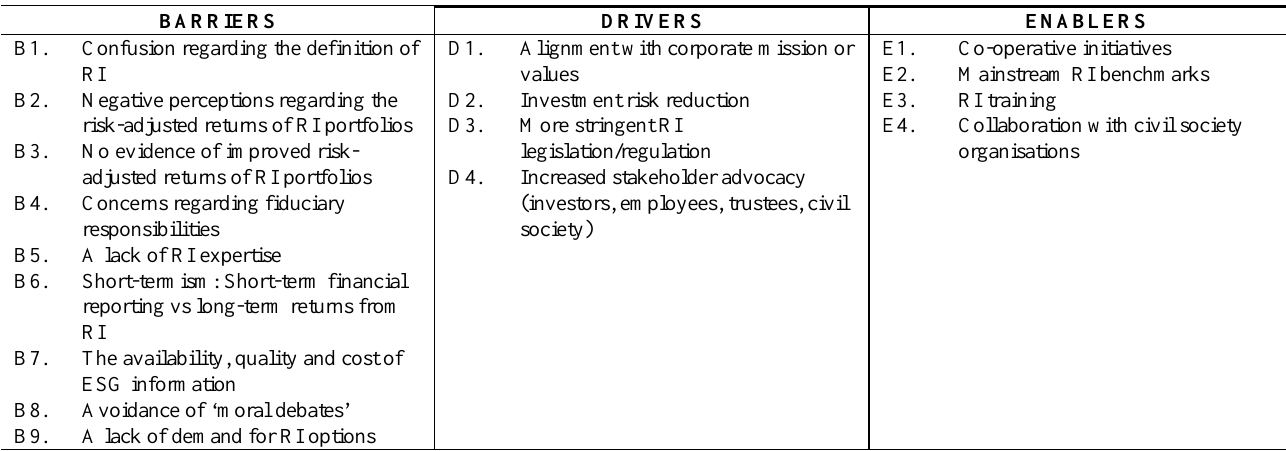
Table 1: The barriers, drivers and enablers of RI in South Africa